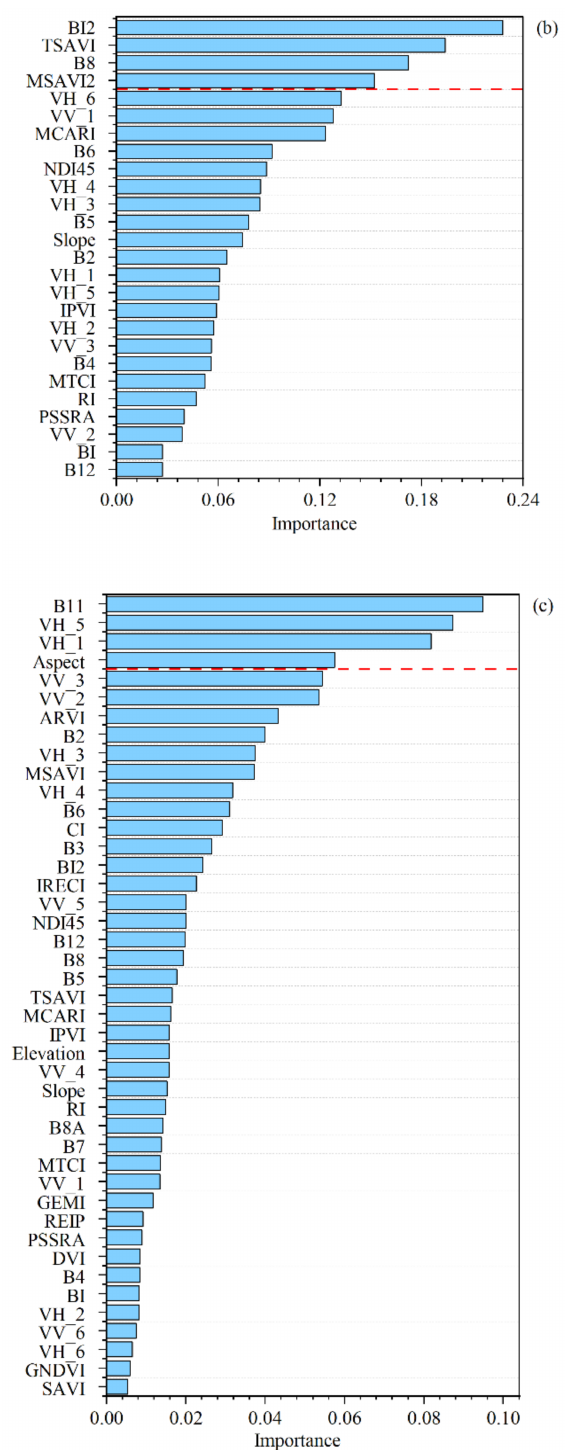
Figure 6. Feature importance based on Model D with the selected features from DEM, Sentinel-1, and Sentinel-2 under orchard ( a ), dry land ( b ), and paddy field ( c ). VV_1 to VV_6 are the backscatter coefficients of VV polarization of six Sentinel-1 images, respectively (Table 1); VH_1 to VH_6 are the backscatter coefficients of VH polarization of six Sentinel-1 images, respectively (Table 1); other abbreviations are soil radiometric indices and vegetation radiometric indices of Sentinel-2 image (the meanings of these indices can be found in Appendix A: Table A1); the relative importance of the features above the red dotted line is greater than